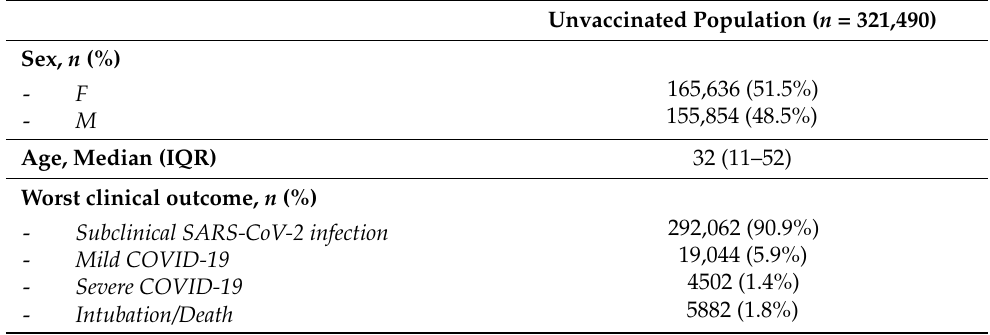
Table 1. Socio-demographic and clinical characteristics of the COVID-19 cases included in the study.